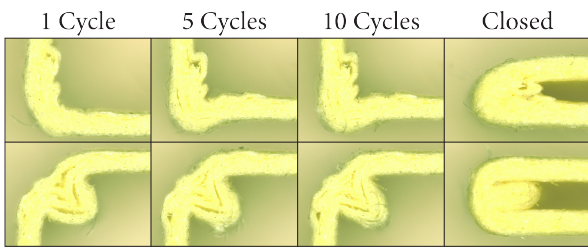
Figure 13. Cyclic fatigue for cardstock. Top row of images are the regular folds, bottom row the reverse folds. Columns from left to right are the following cycles: 1, 5, 10, and close fold.